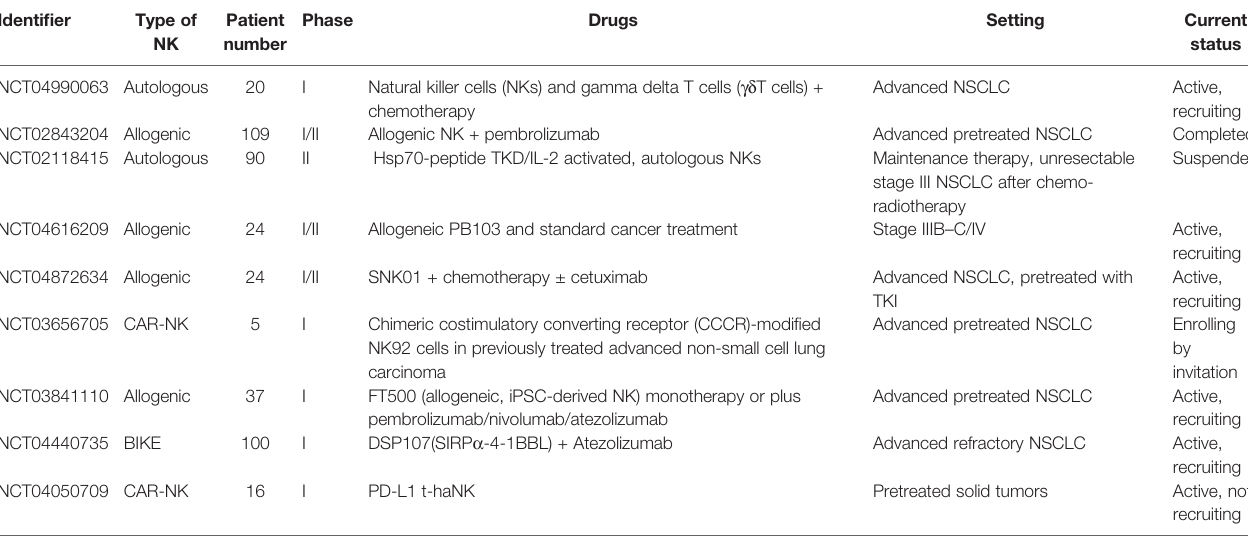
TABLE 2 | Current clinical trials on adoptive and CAR-NK therapy in